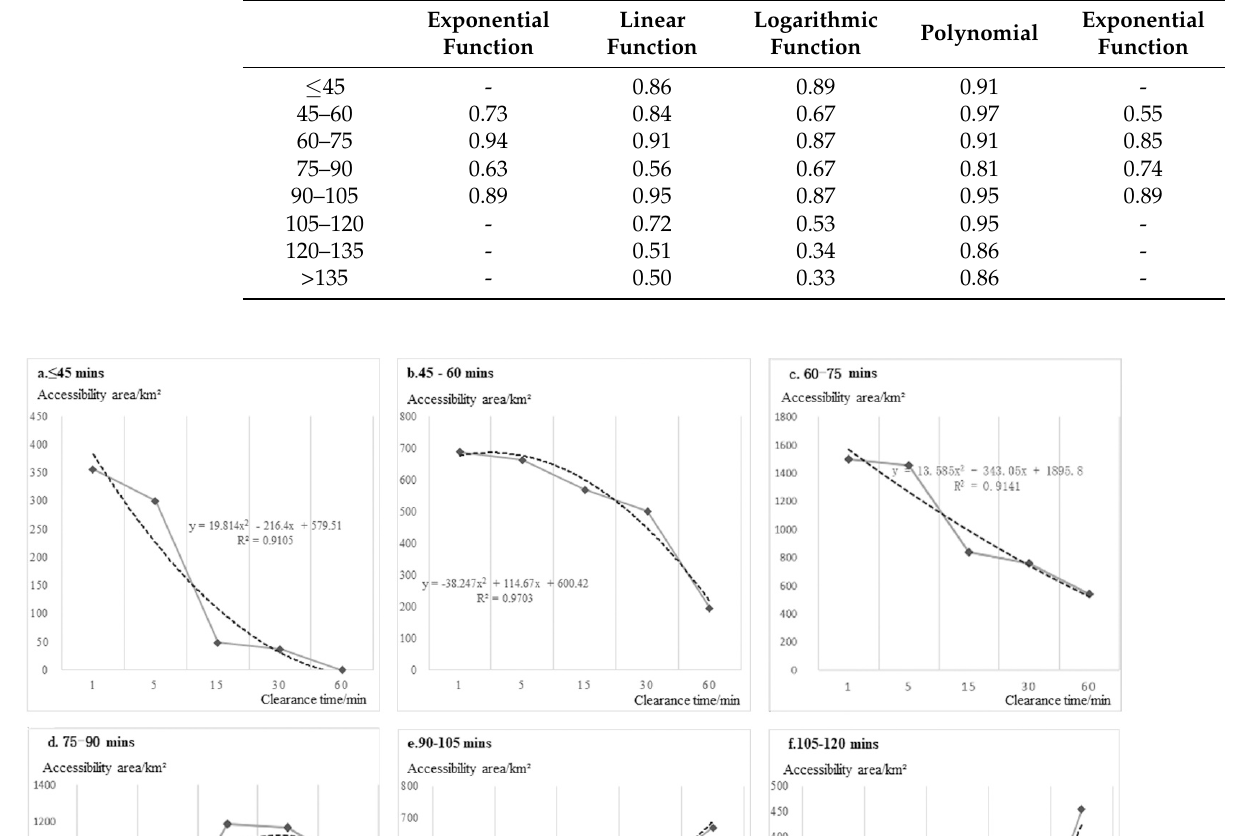
Table 7. R 2 of the fitting function of the change in accessible areas.